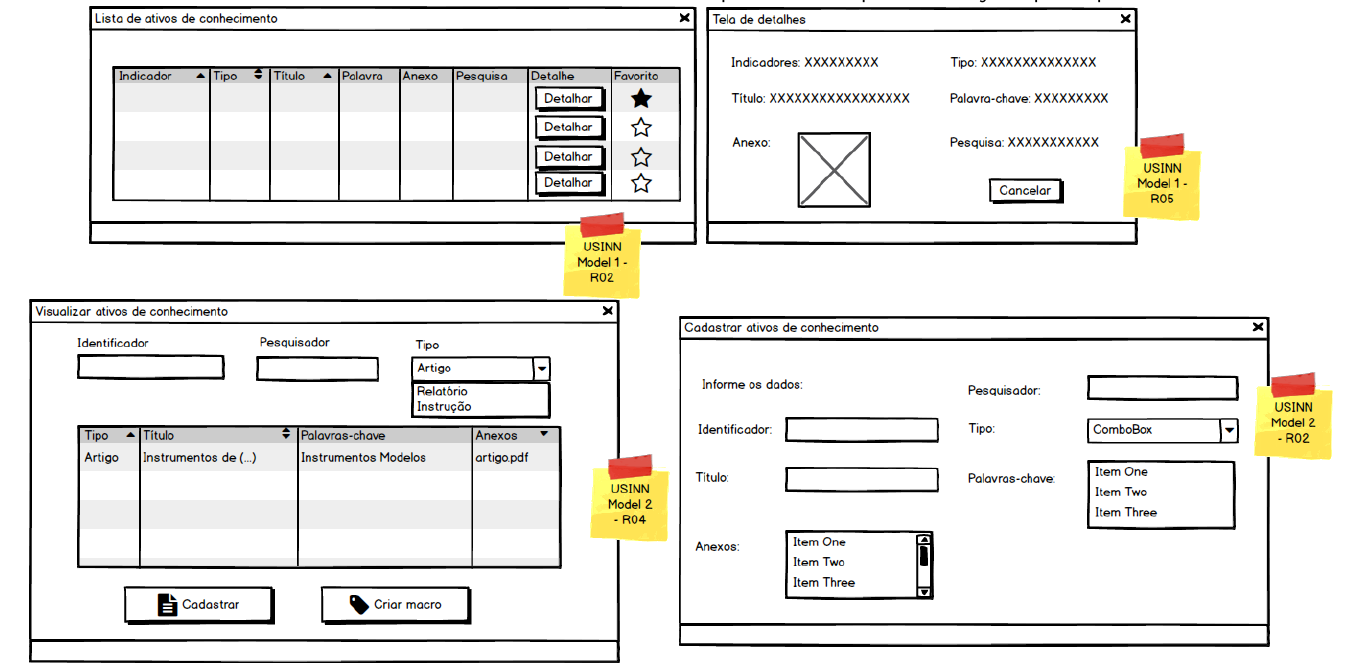
Fig. 5. Examples of mockups created by the